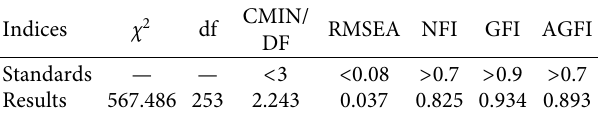
Table 7: Results of confrmatory factor